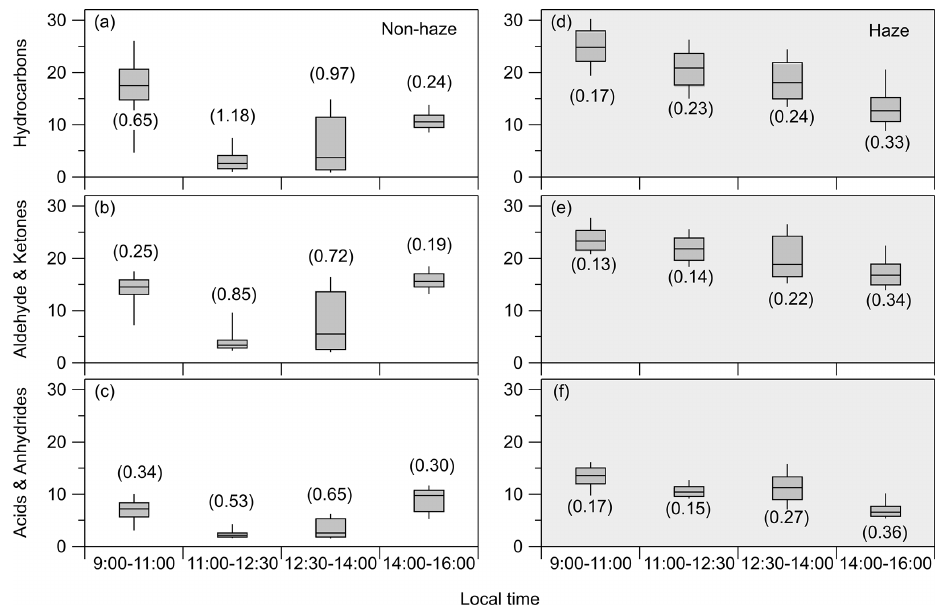
Figure 7. Spatiotemporal distributions of the mixing ratios (units: ppbv) of (cid:80) hydrocarbons, (cid:80) aldehydes and ketones, and (cid:80) acids and anhydrides, measured during the non-haze and haze days. The box and whisker plots show median, 75th and 25th percentiles, 90th and 10th percentiles of all the data points. The numbers in parentheses represent the CV values. Data covered from 09:00 to 16:00 during the measurement